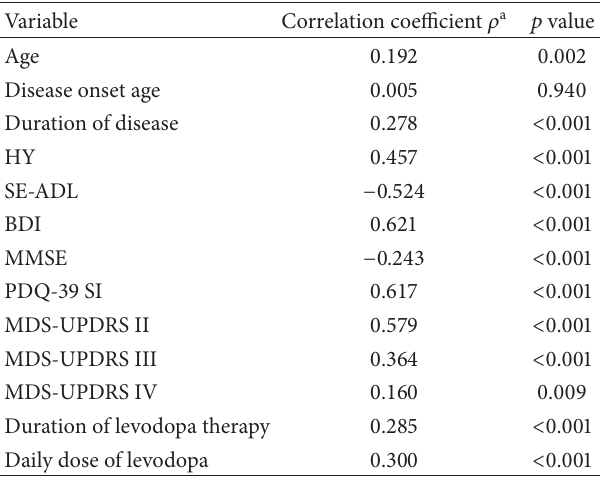
Table 3: Correlation analysis between the total score of nonmotor symptoms assessed by the MDS-UPDRS Part I and